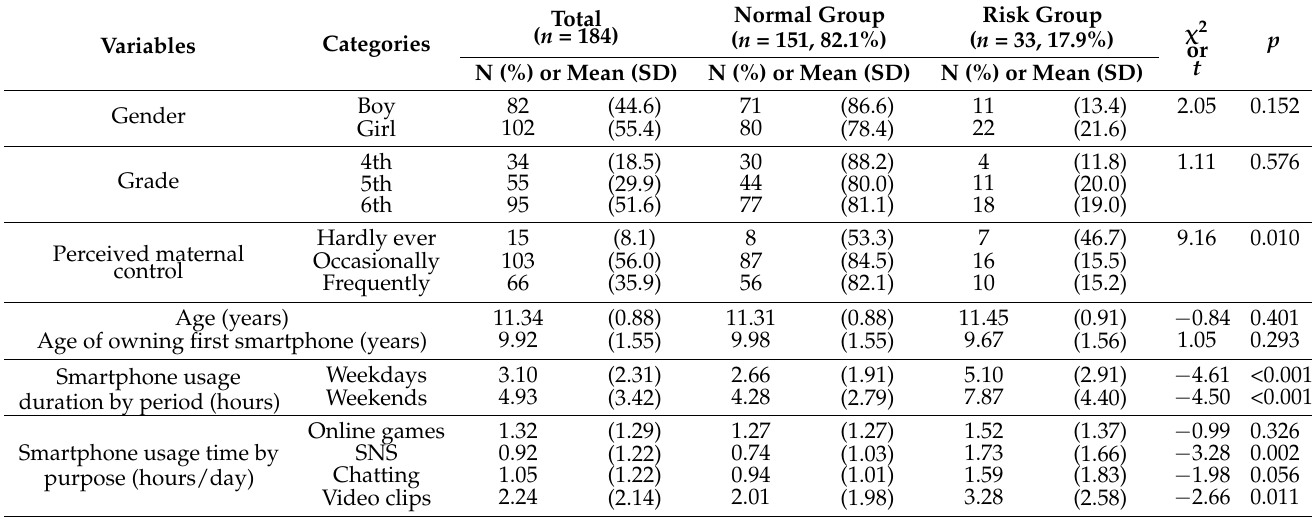
Table 1. Differences in general and smartphone characteristics according to normal and risk group of PSU ( n = 184).